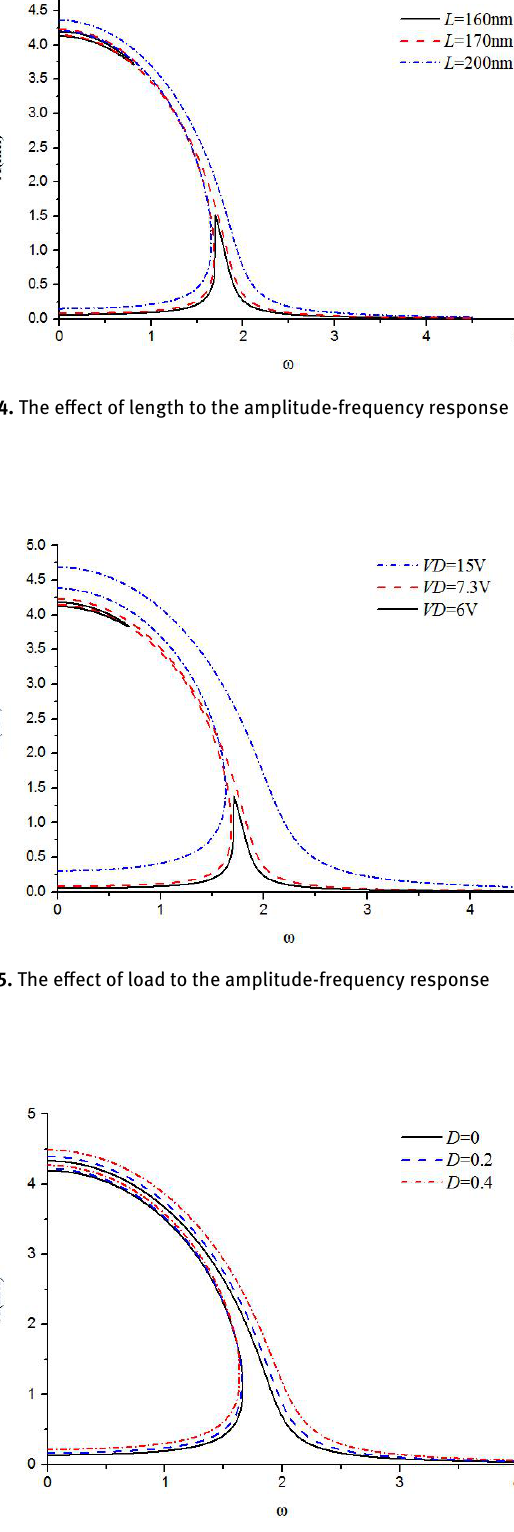
Fig. 6. The effect of damage to the amplitude-frequency